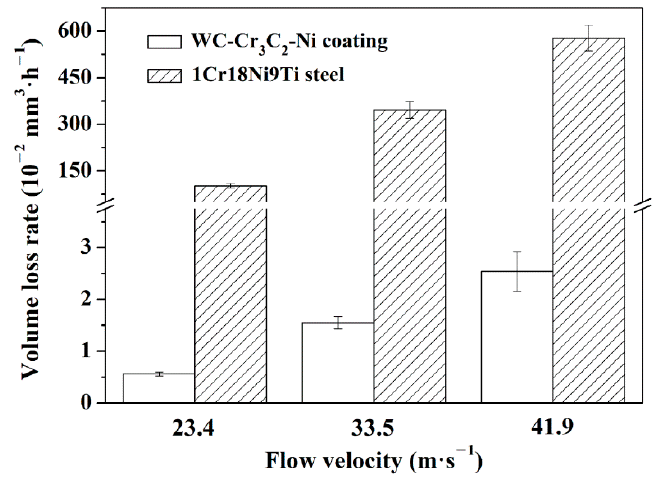
Figure 3. Volume loss rates of the WC-Cr 3 C 2 -Ni coating and the 1Cr18Ni9Ti stainless steel after HAE for 6 h in 3.5 wt.% NaCl aqueous solution at 20 kg·m − 3 and different FVs. After 6 h of HAE in the 3.5 wt.% NaCl aqueous solution at 20 kg·m − 3 and different